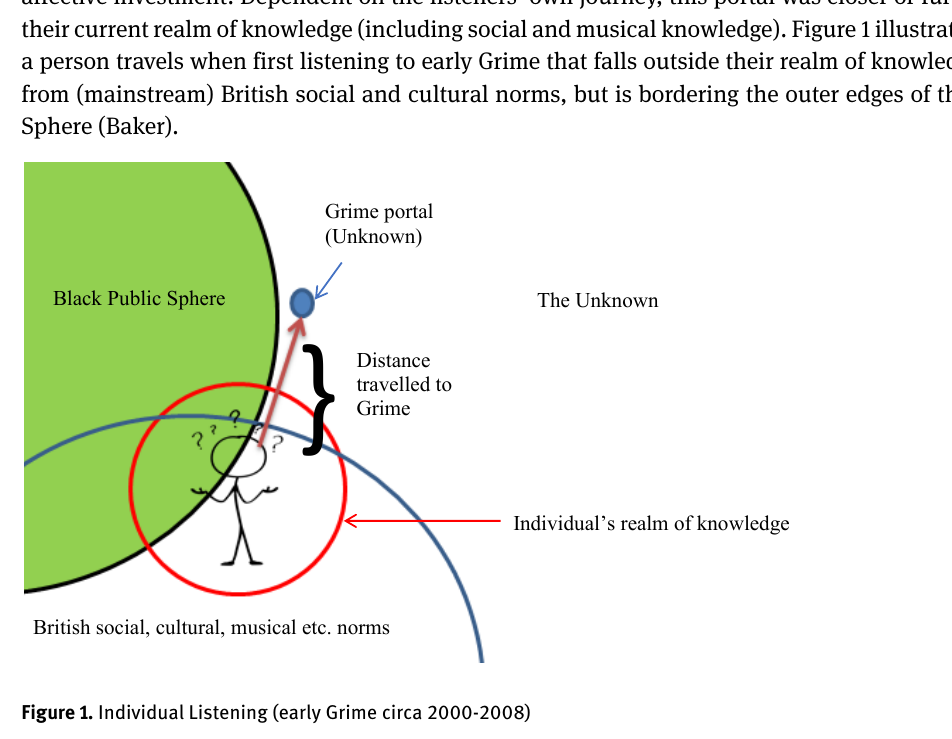
Figure 1. Individual Listening (early Grime circa